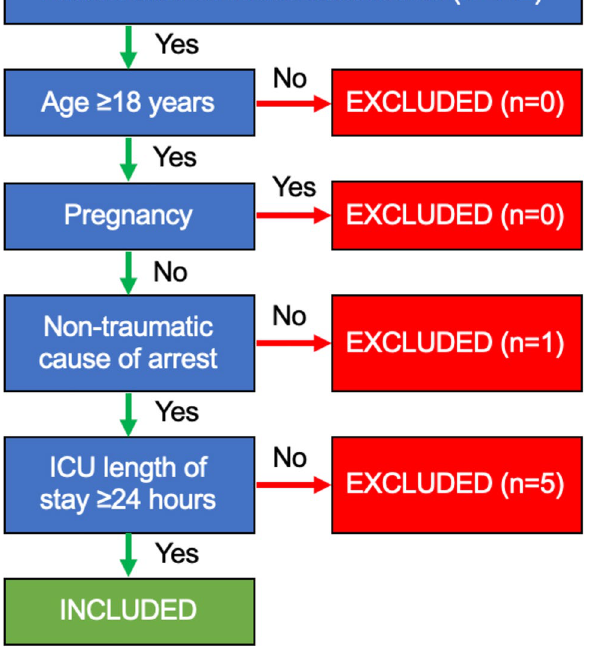
Figure 1. Patient enrollment process. CPR cardiopulmonary resuscitation, ICU intensive care